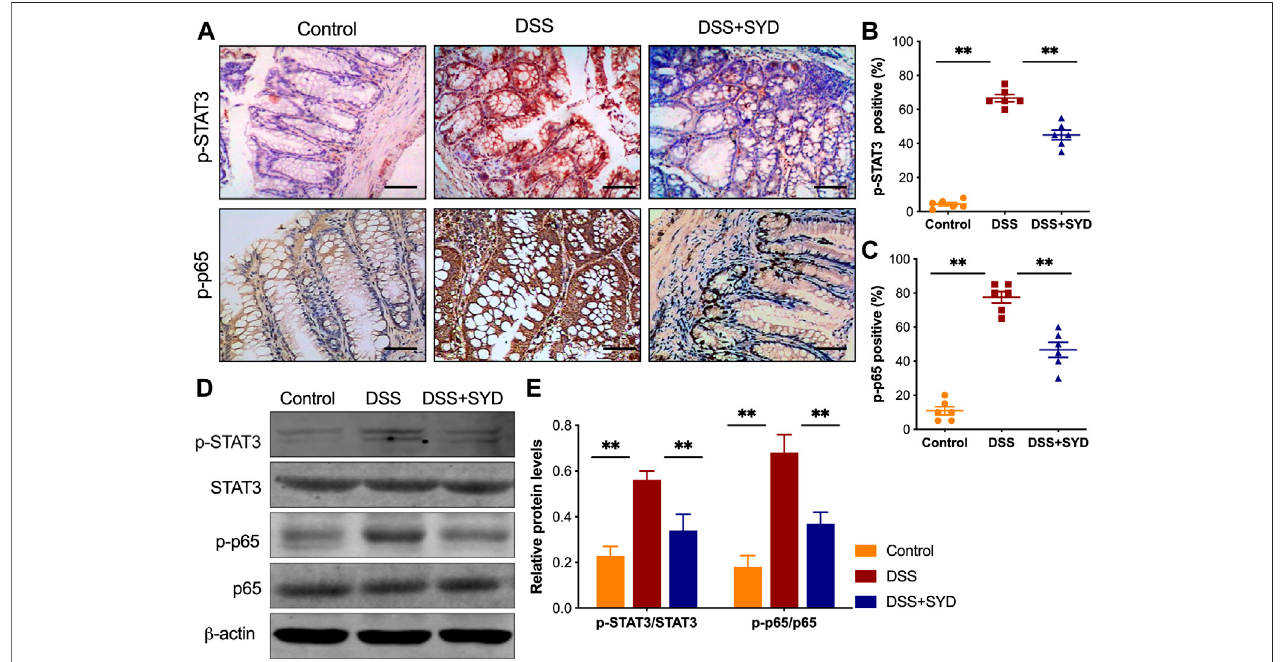
FIGURE 4 | SYD inhibits the activation of STAT3 and NF- κ B signaling in colon tissues of DSS-induced colitis mice (A) Immunohistochemistry of p-STAT3 and p-p65incolonsections.Scalebars (cid:2) 100 μ m (B,C) Graphicalrepresentationofp-STAT3andp-p65-positivecellsinthemid-colon (D,E) Theproteinlevelsofp-STAT3, STAT3, p-p65, and p65 were measured by western blotting with relative densitometric values calculated as ratio of P- stat3/Stat3 and p-p65/P65. Each western blot is representative of three independent experiments. Data are presented as the mean ± SEM, n (cid:2) 6 per group. * p < 0.05, ** p <